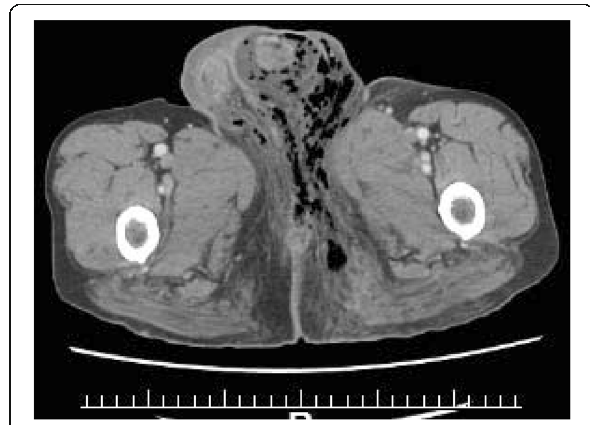
Fig. 4 Extensive emphysema in the scrotum and gluteus maximus